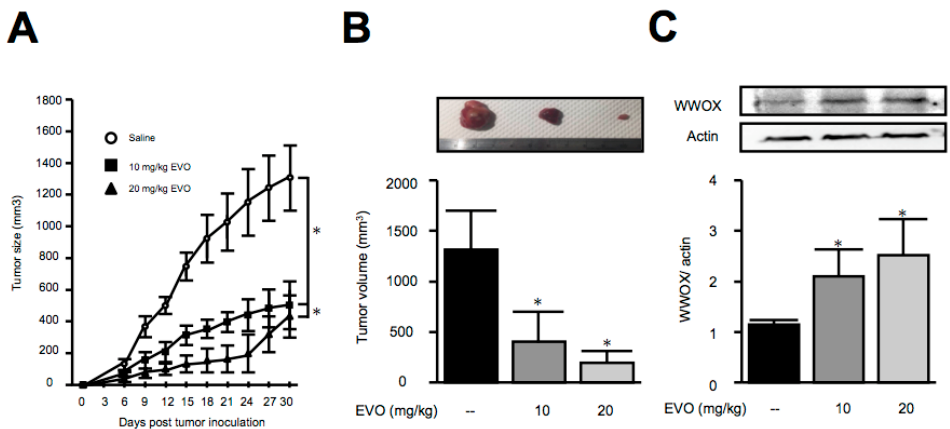
Figure 3. Evodiamine decreased tumor size in Hepa1-6 hepatoma-bearing mice. Hepa1-6 cells were